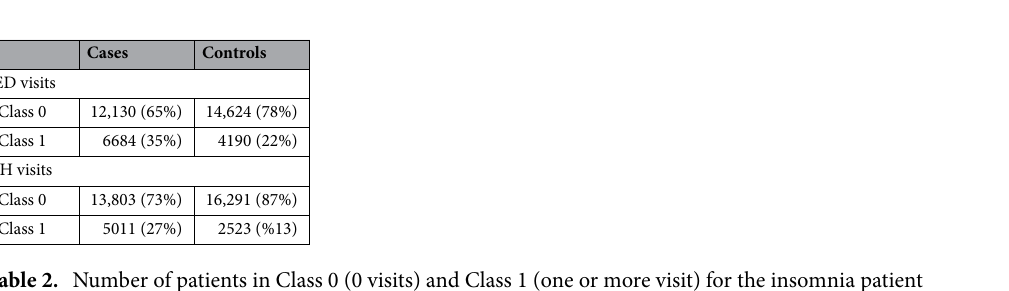
Table 2. Number of patients in Class 0 (0 visits) and Class 1 (one or more visit) for the insomnia patient cohort (cases) and the general population cohort (controls).